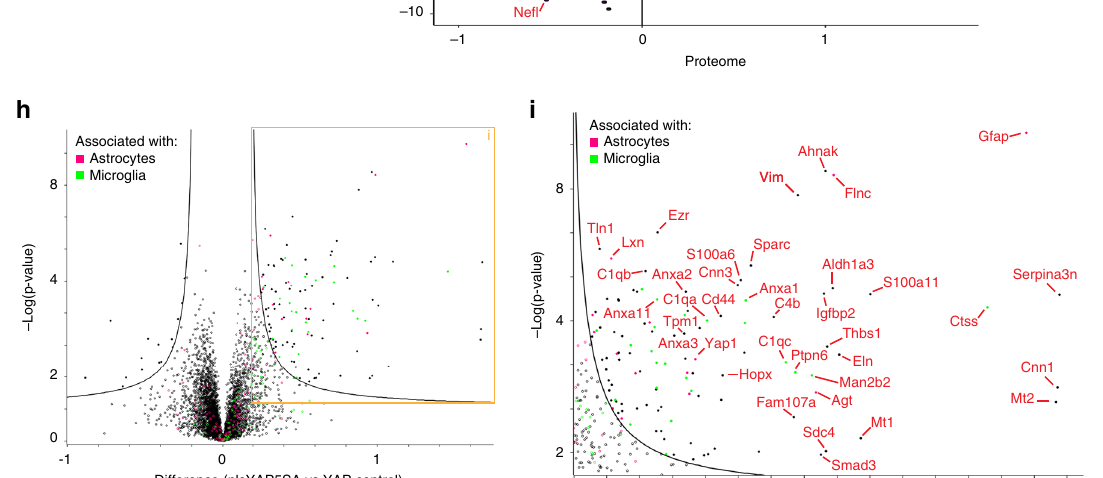
nlsYAP5SA we found pathways in cancer, cytokine receptor interaction and focal adhesion, in agreement with active YAP1 ’ s capacity to induce cancer and a consequent immune response (Fig. 6b, c). On the other side, Oxidative Phosphorylation gene set among the most reduced, which may indicate changes in